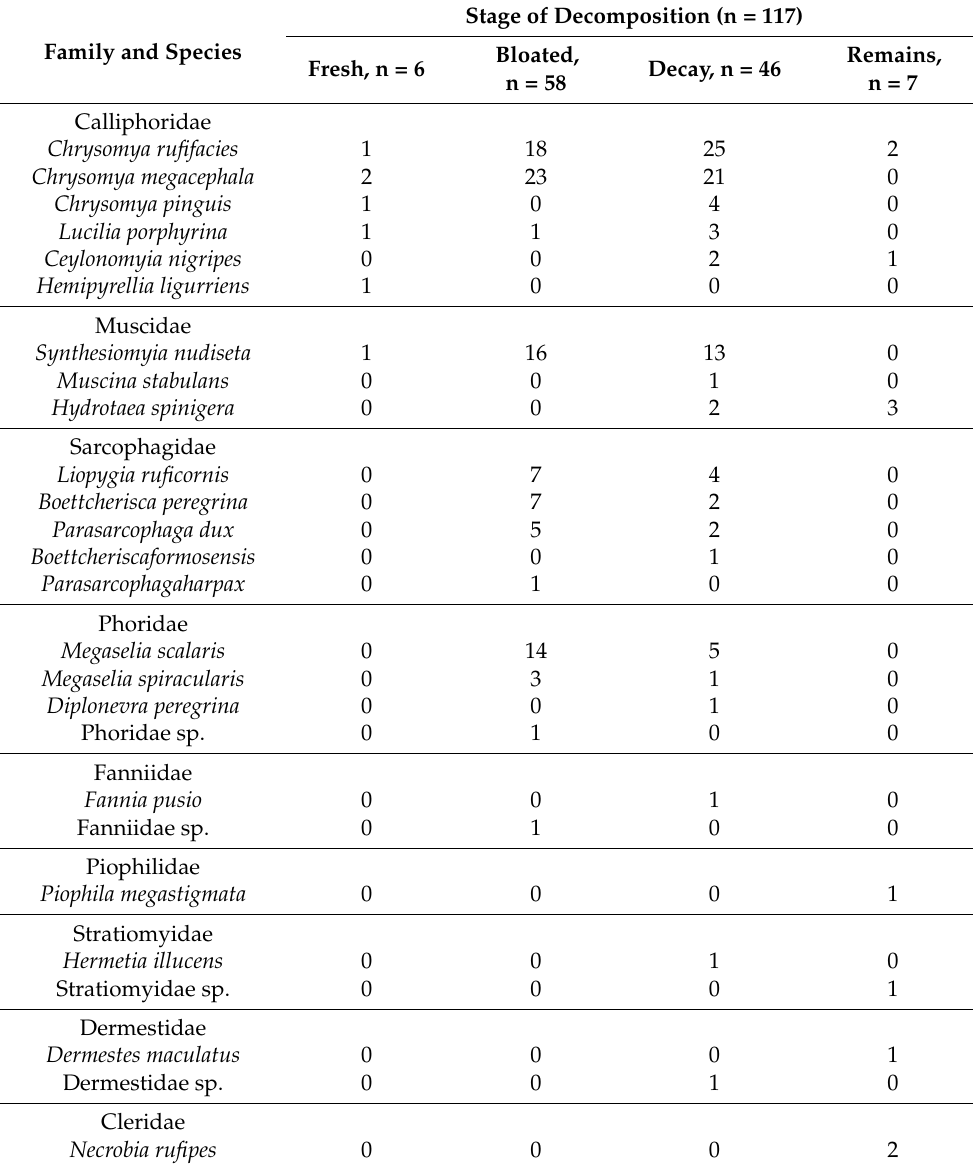
Table 2. Case frequency of fly species collected in different stages of human decomposition from 114 forensic cases in Taiwan from 2011 to 2018. (n, number of